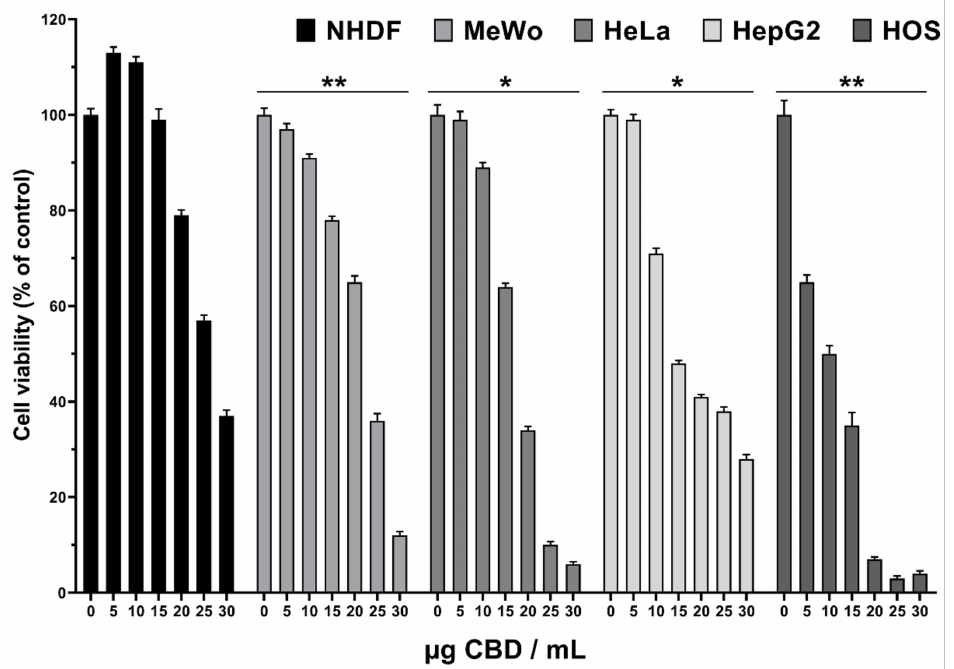
Figure 6. Cytotoxicity of CBD-enriched hemp oil on normal dermal fibroblasts (NHDF), malig- nant melanoma (MeWo), adenocarcinoma (HeLa), hepatocellular carcinoma (HepG2) and osteosar- coma (HOS) cells. Control cells were incubated with complete cell culture medium (represented as 0 µ g CBD/mL). Treated cell viability was expressed as a percentage of control cells’ viability. Data were represented as means ± standard error of the mean. * p < 0.05, ** p < 0.01 vs. NHDF cells (one-way ANOVA: MeWo p = 0.0052, HeLa p = 0.0149, HepG2 p = 0.0400, HOS p = 0.0065).